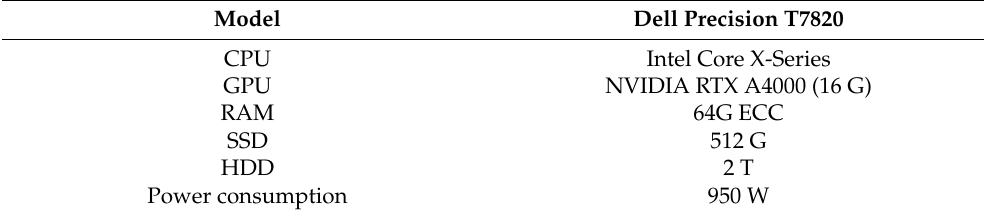
Table 1. The main configuration and model parameters of the server used in training. Model